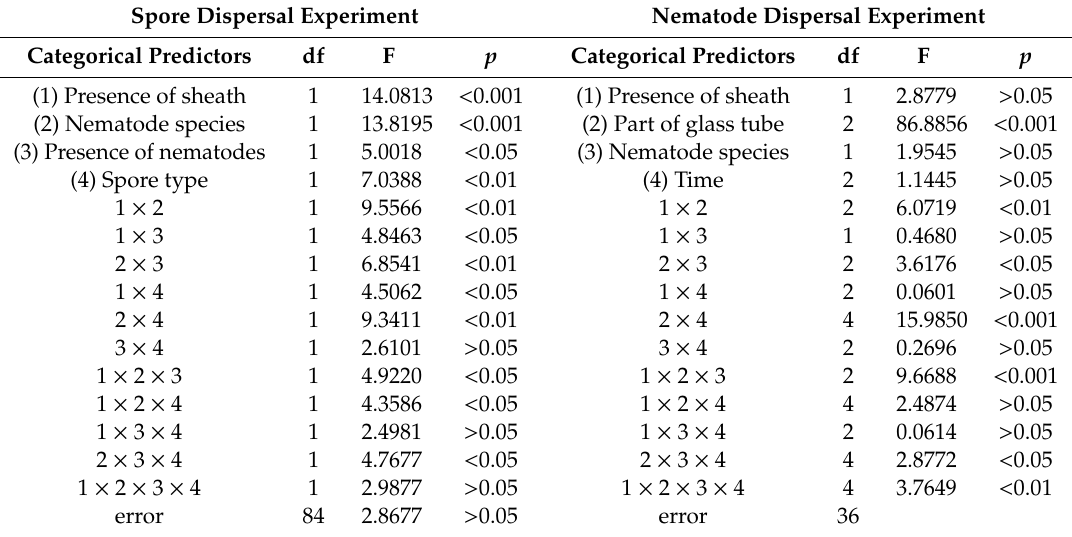
Table 2. Glass tube experiments—fungi and nematodes’ dispersal: Complete results of factorial ANOVA including interactions that are not presented in the text; degrees of freedom (df), test criterion (F), p -value ( p ), numbers 1–4 indicate respective categorical